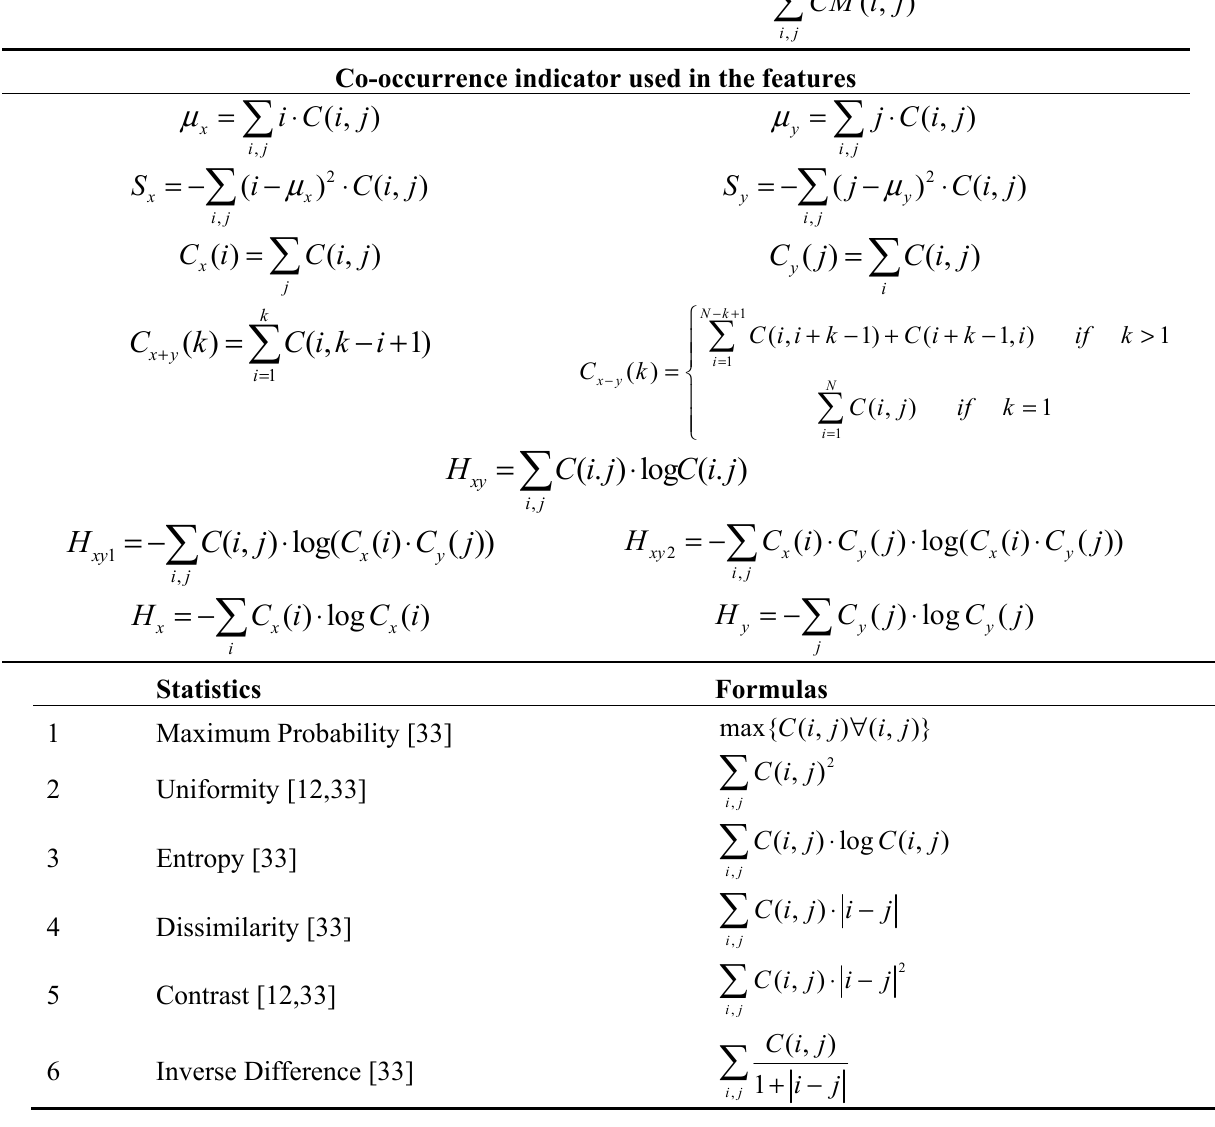
Table A1. List of statistics used for GLCM feature calculations. The GLCM feature vector consisted of 22 features calculated from the following table. C is the L1 normalized co-occurrence matrix (defined over an image to be the distribution of co-occurring values at a given offset). The pixel row and column are represented by i and j . N is the number of distinct gray levels in a quantized image (we used 16 in our case), µ and S are the mean and standard deviation and H is the entropy of C . C is a N by N matrix. I is the input image of n × m size. The offset is [ Δ x Δ y ]. We used [0 3], [ − 3 3], [ − 3 0], [ − 3 − 3] offset values; calculated statistics individually for each features and then averaged to get final results. These offset values represent 0, 45, 90 and 135 degrees angular neighborhood with a distance of three pixels from the center